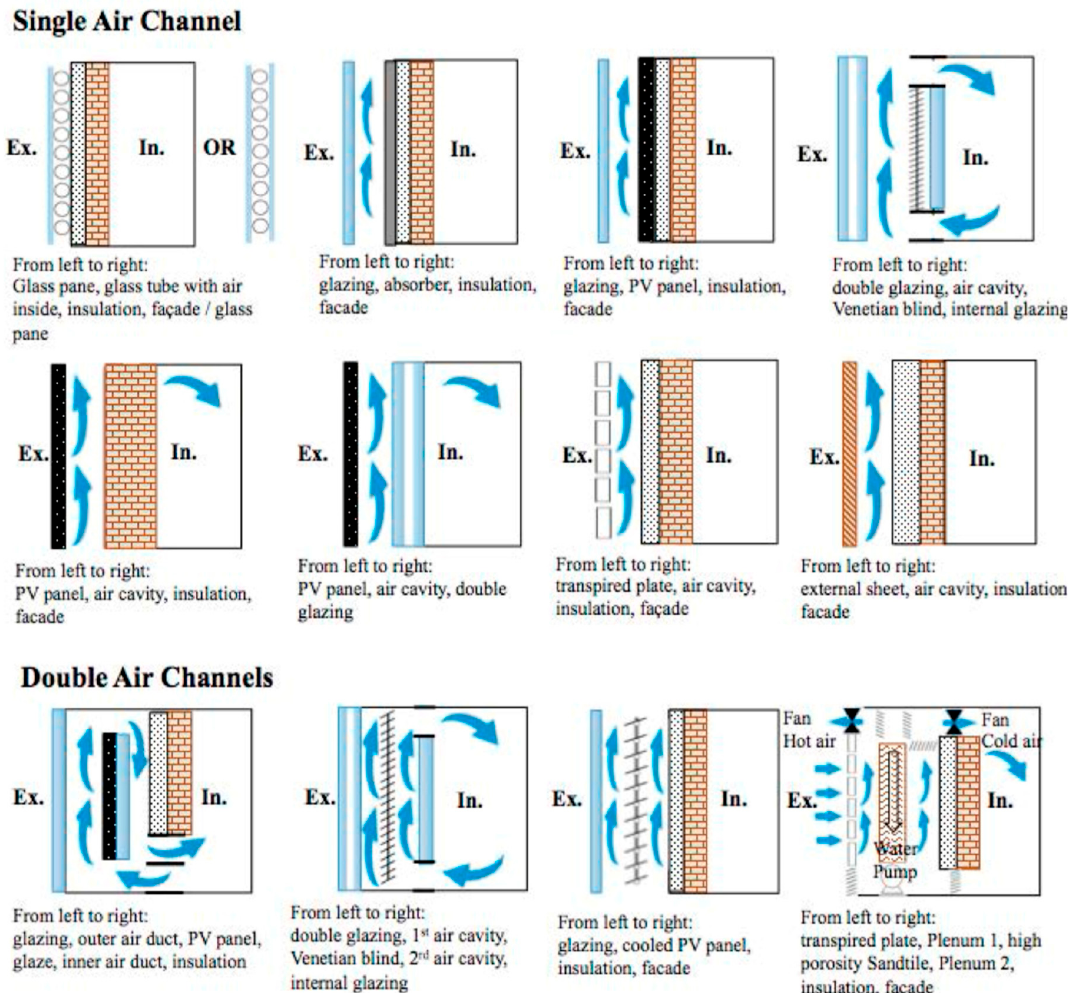
Figure 7. Schematics of different air-based building integration with PV